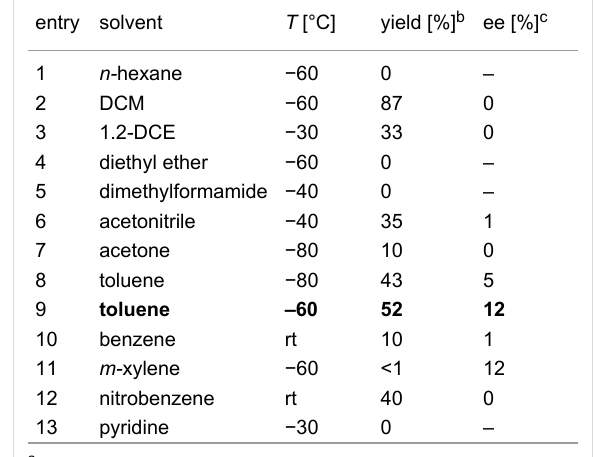
Table 7: N -acyl Mannich reaction of 10 and 11c catalyzed by silane- diol 9 yielding product 12 with different solvents (Scheme 6) a